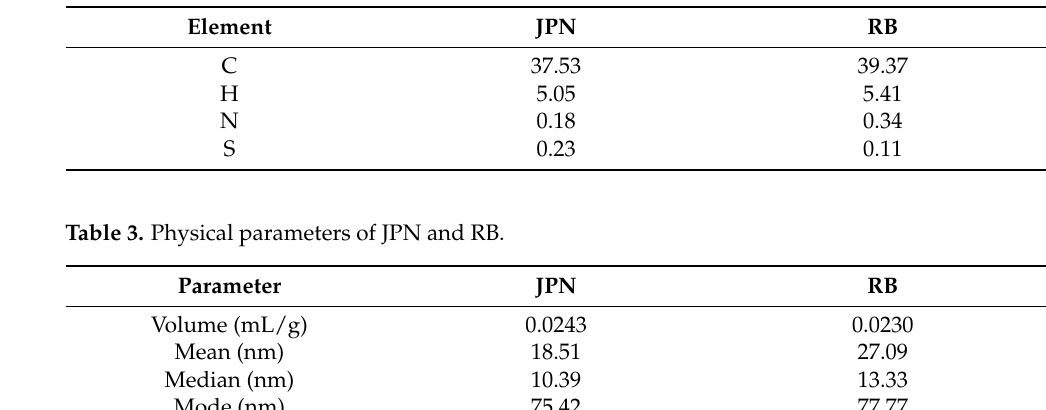
Table 2. C, H, N, S ultimate analysis of JPN and RB fuel samples in wt.%db.